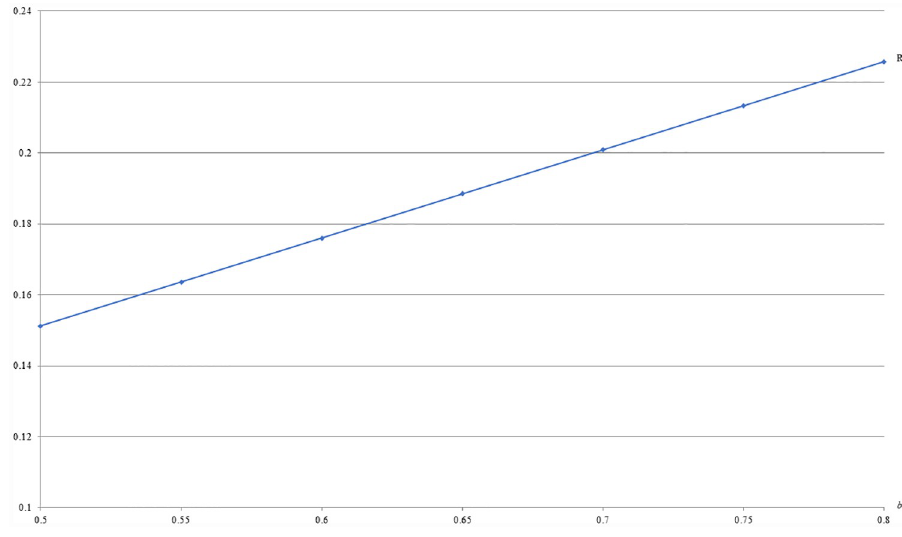
Fig 2. An illustration of the relation between revenue and b under IB.